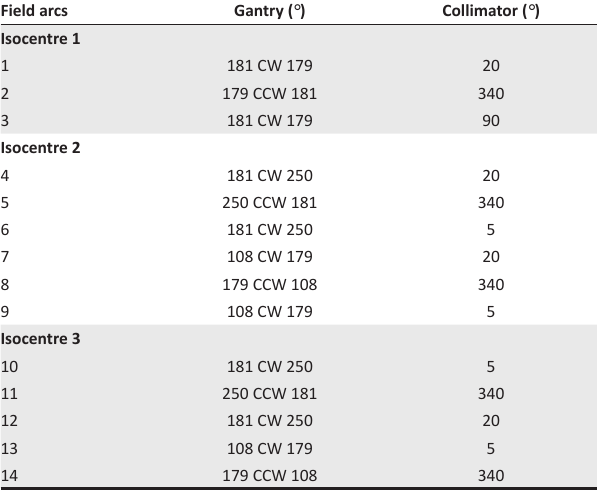
TABLE 2: Volumetric modulated arc therapy gantry and collimator angles per field per isocentre. Field